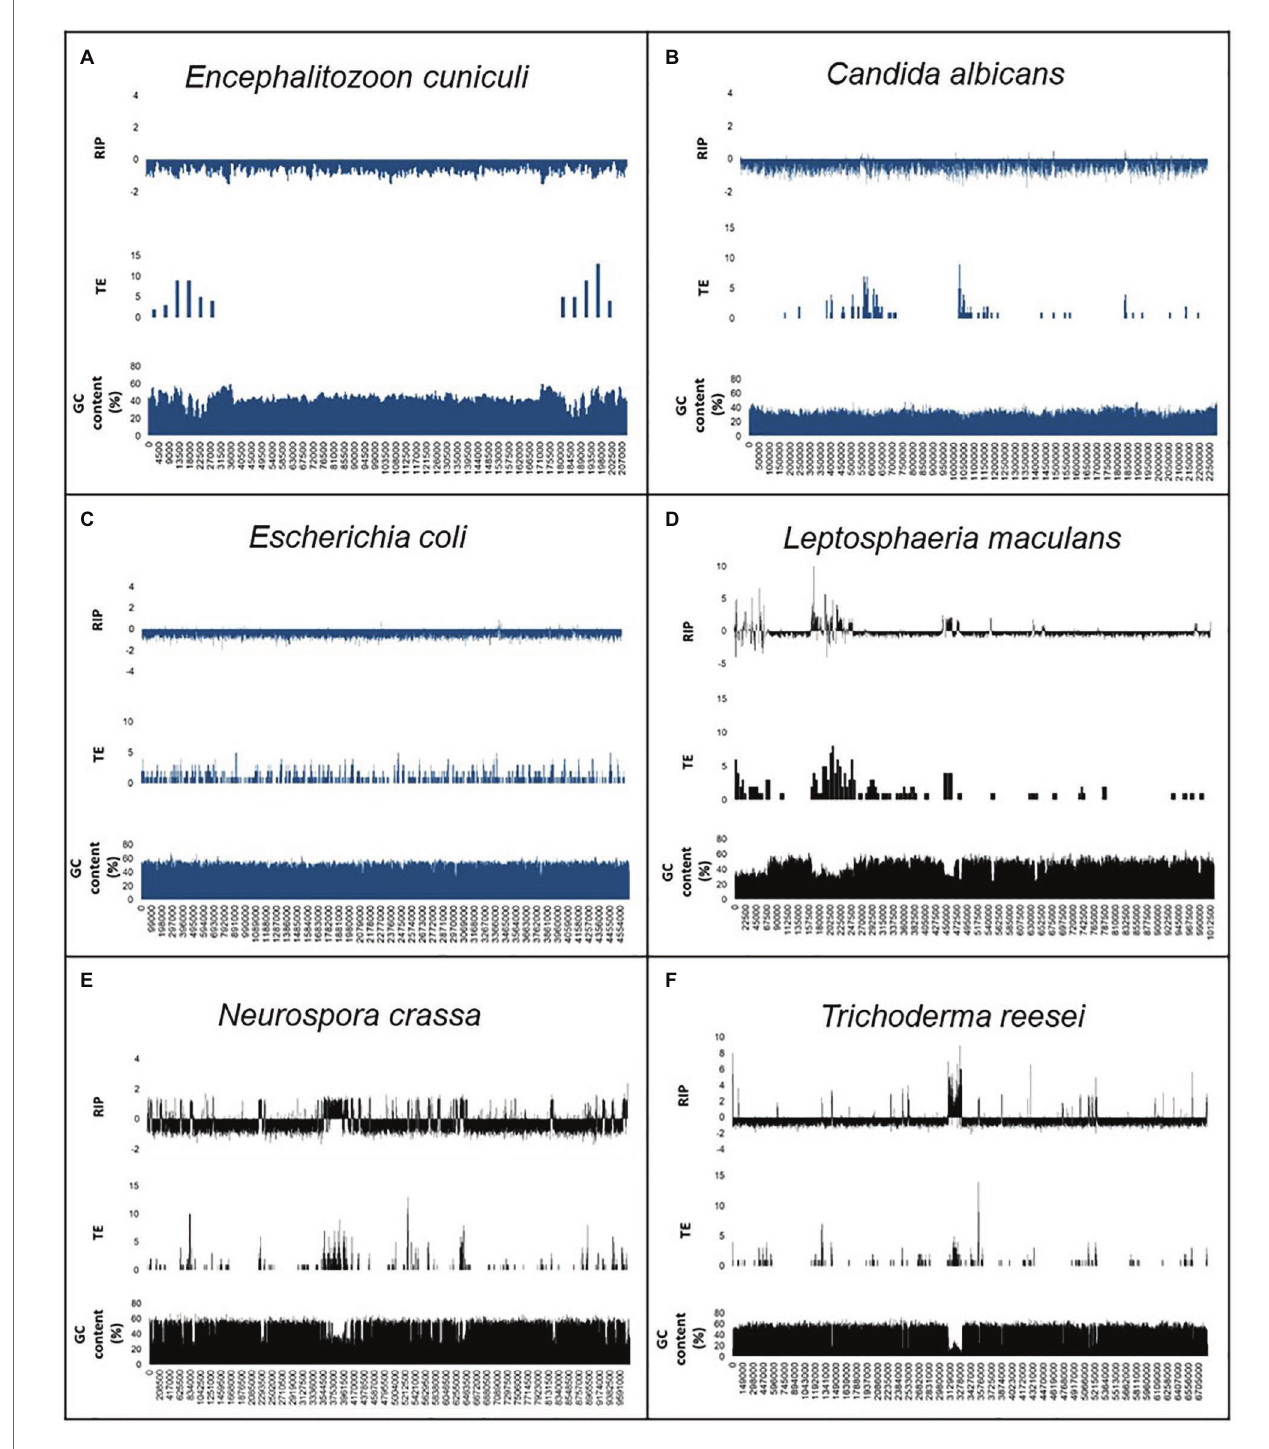
FIGURE 2 | Summary of the genomic features for the RIP-negative (A–C) and RIP-positive (D–F) control organisms used in this study. The first scaffold or chromosome is indicated for En. cuniculi (A) , Ca. albicans (B) , Le. maculans (D) , N. crassa (E), and Tr. reesei (F) , while the whole chromosome of E. coli (C) are shown. In each panel, the first row shows changes in RIP composite index values, where values > 0 indicate RIP. The second and third rows show the number of transposable elements [TEs; calculated for every 10 and 5 kilo base pair (Kbp) increments] and GC content (calculated for every 1,000 and 500 bp increments). A full list of genome-wide RIP statistics, implementing stringent parameters, is available for these organisms in Supplementary Table S5 . Results for the negative control organisms are indicated in blue, and positive control fungi are indicated in